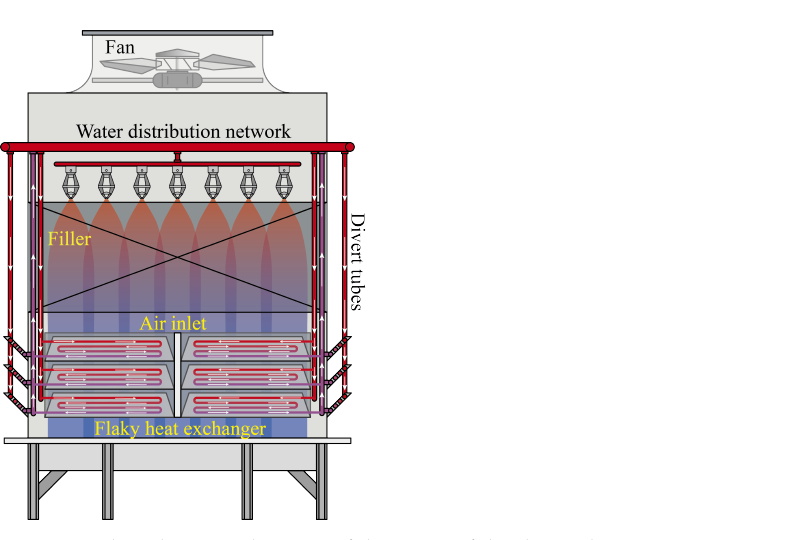
Figure 2. The schematic diagram of the setup of the dry and wet mixing